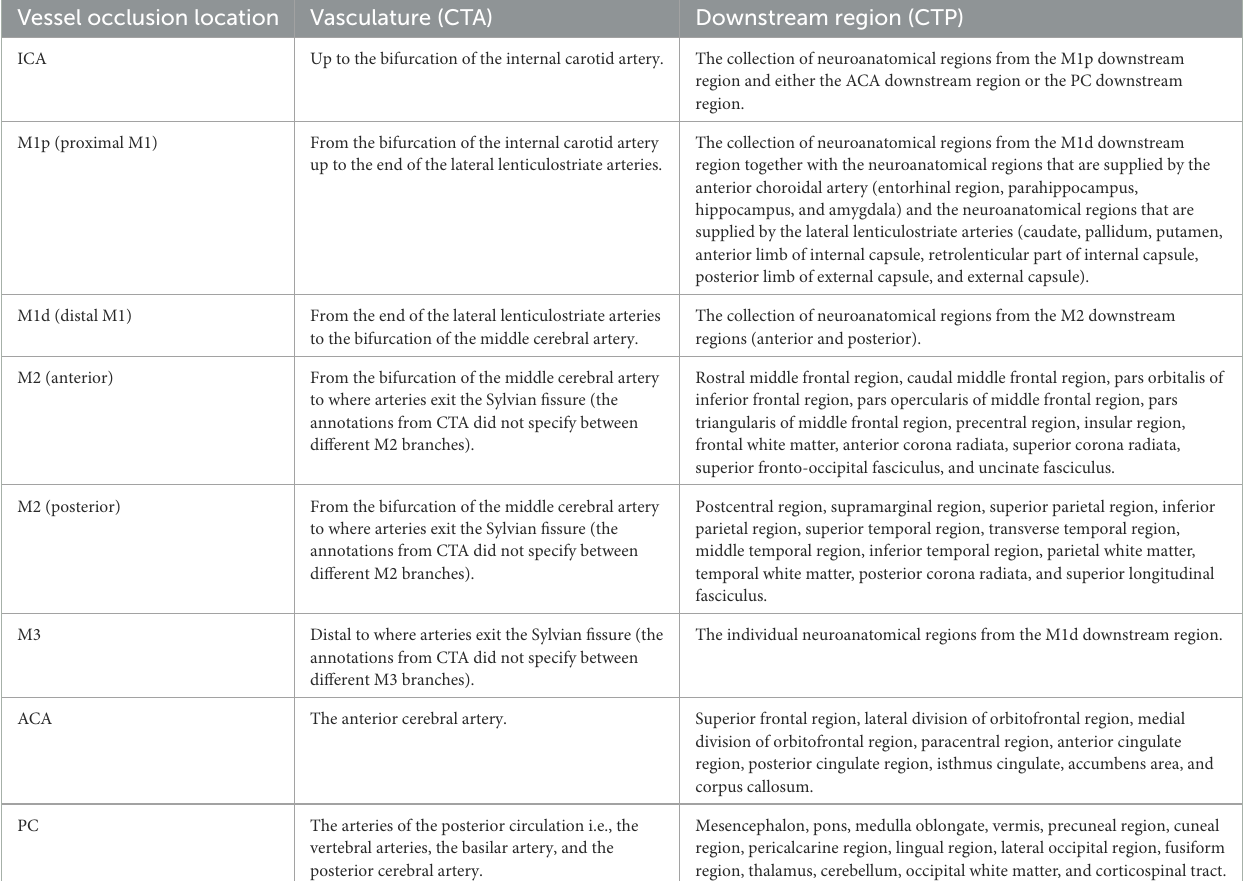
TABLE 1 The definitions of the vessel occlusion locations and their downstream regions. Vessel occlusion